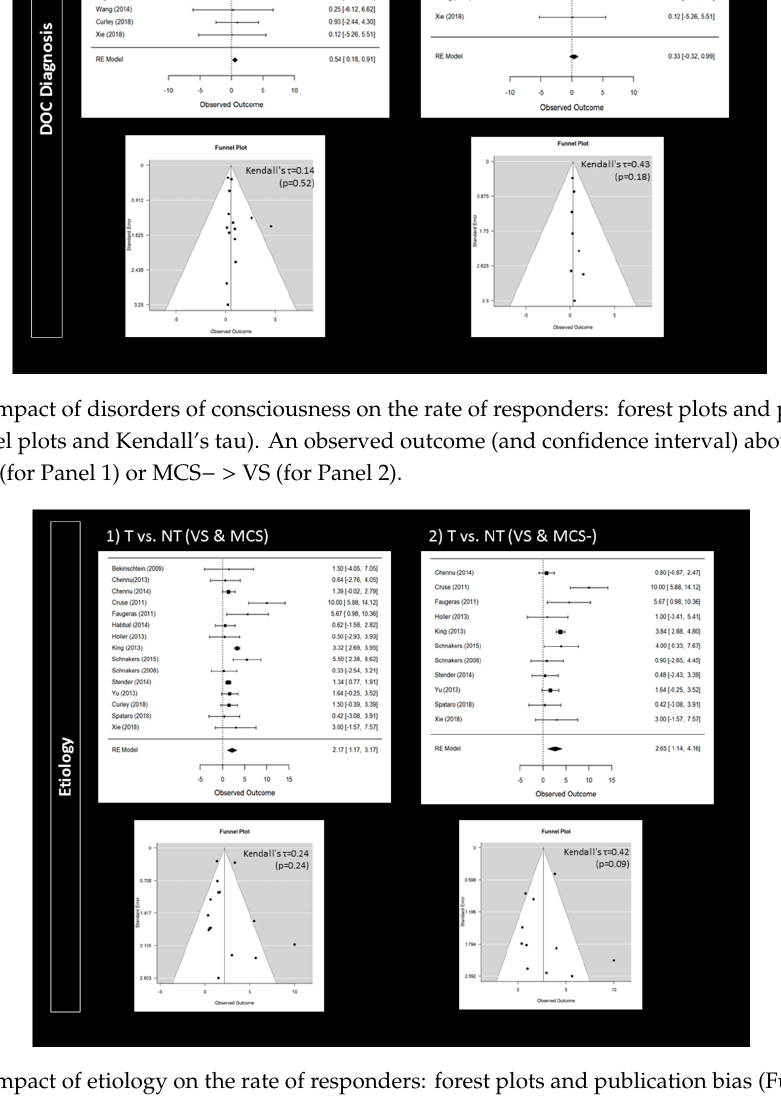
Figure 3. Impact of etiology on the rate of responders: forest plots and publication bias (Funnel plots and Kendall’s tau); Panel 1 illustrates the findings when considering traumatic brain injury (T) versus non-traumatic brain injury (NT) in VS and in MCS patients. Panel 2 illustrates the findings when considering traumatic brain injury (T) versus non-traumatic brain injury (NT) in VS and in MCS − patients. An observed outcome (and confidence interval) above 0 means T > NT (for both Panel 1 and 2).